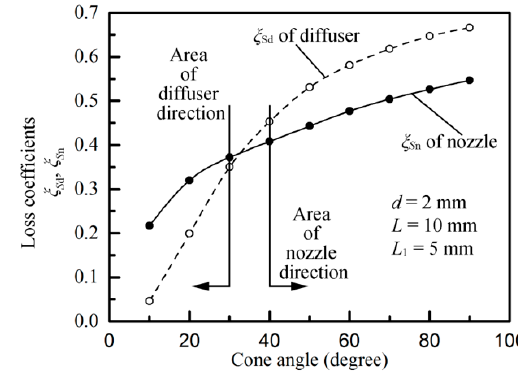
Figure 4. Empirical curves of the cone angle, the diffuser loss coefficient ξ S d , and the nozzle loss coefficient ξ S n .